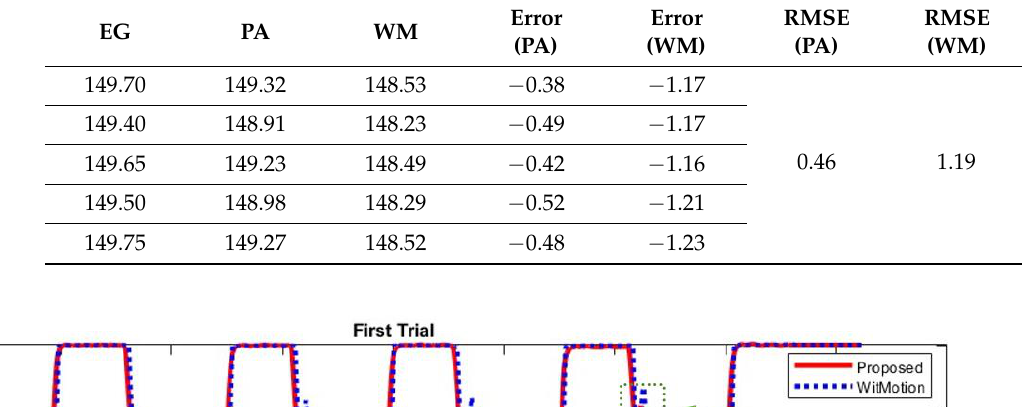
Table 4. RMSE ( ◦ ) of the joint angle (first trial).